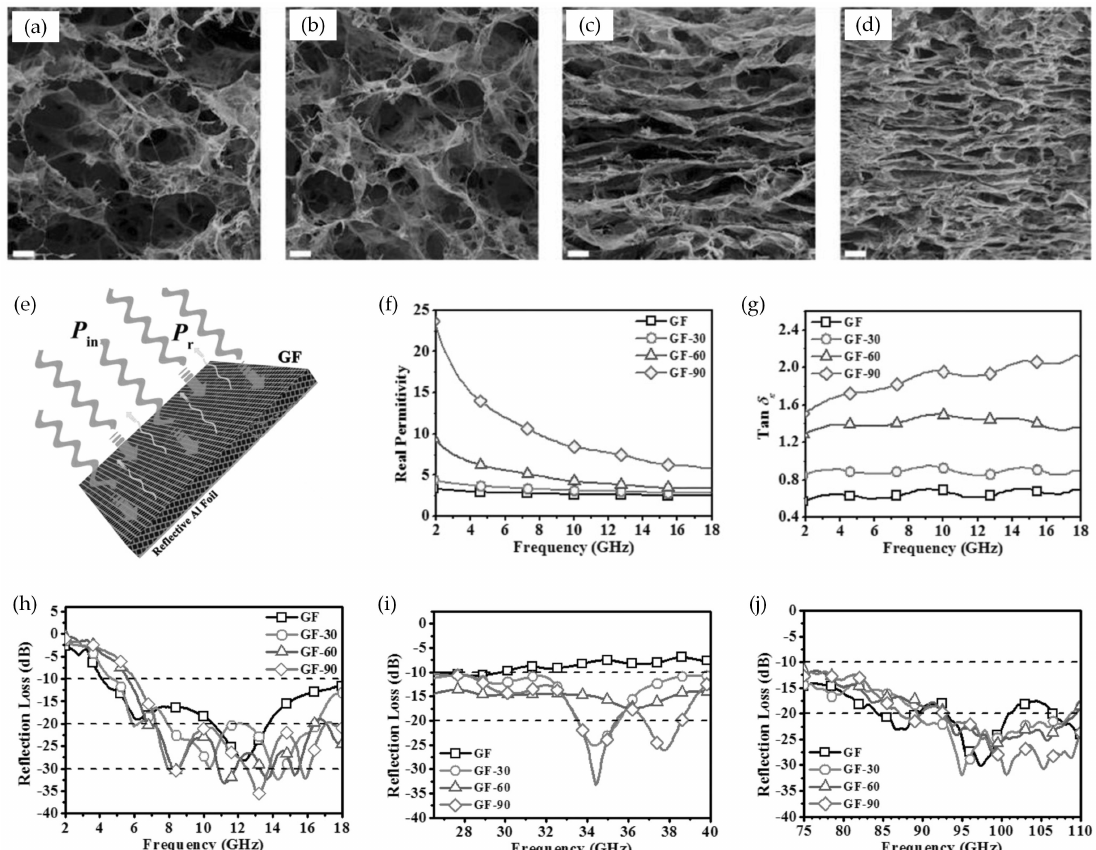
Figure 3. The cross-sectional SEM images of ( a ) graphene foam (GF) and GF under ( b ) 30%; ( c ) 60%; and ( d ) 90% compressive strains. The length of scale bar is 20 µ m; ( e ) the schematic of GF Dällenbach absorber. The measured electrical properties of GF-30, GF-60 and GF-90: ( f ) the real part of complex permittivity; ( g ) the loss tangent. The measured return loss (RL) spectra of GF-30, GF-60 and GF-90 for ( h ) 2–18 GHz; ( i ) 26.5–40 GHz and ( j ) 75–100 GHz, reprinted with permission from Ref.